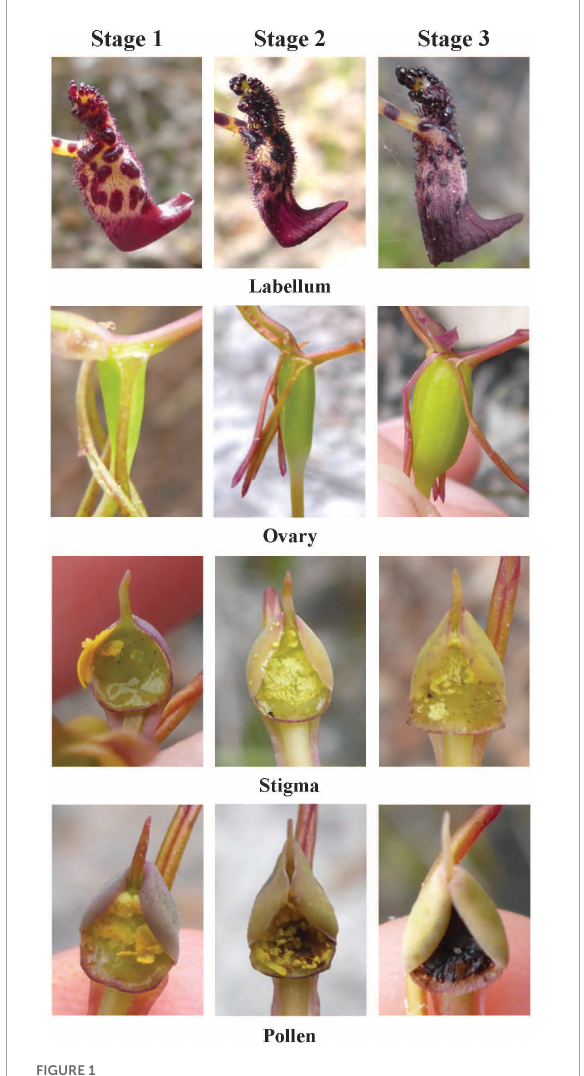
FIGURE1 Flowers displaying different post-pollination stages (stage one being the first stage post-pollination, and stage three being the last) of the labellum, ovary, stigma, and pollen at which chemical sampling was